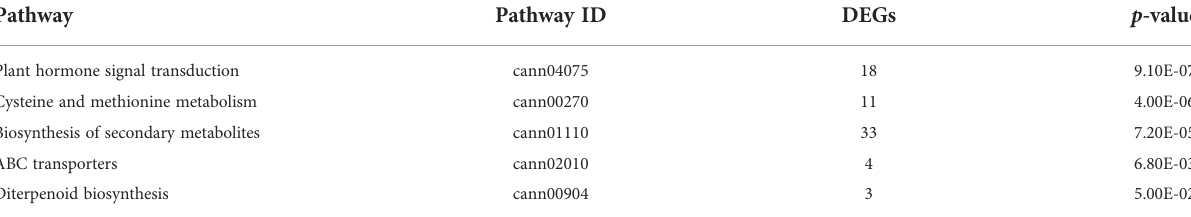
TABLE 3 Top 5 KEGG pathways enriched for DEGs up-regulated in response to CMV